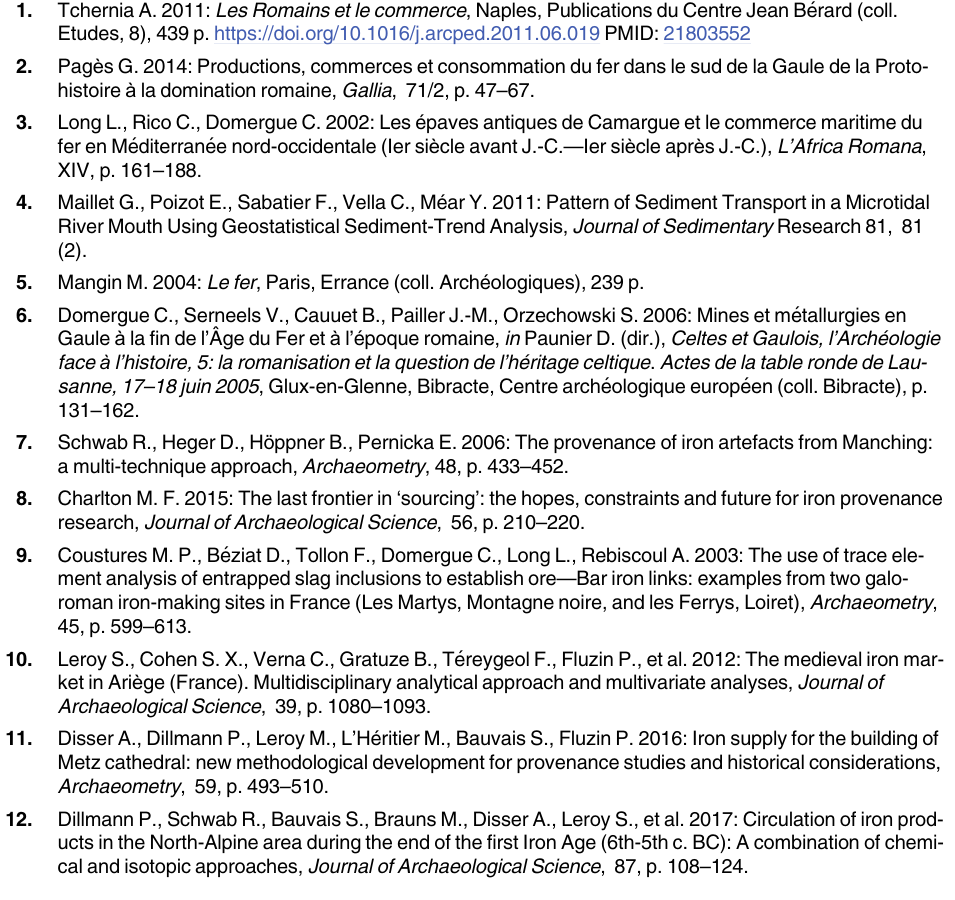
S1 Table. Chemical data of iron production areas and slag inclusions of Primary Pieces of Metal (PPM) of iron